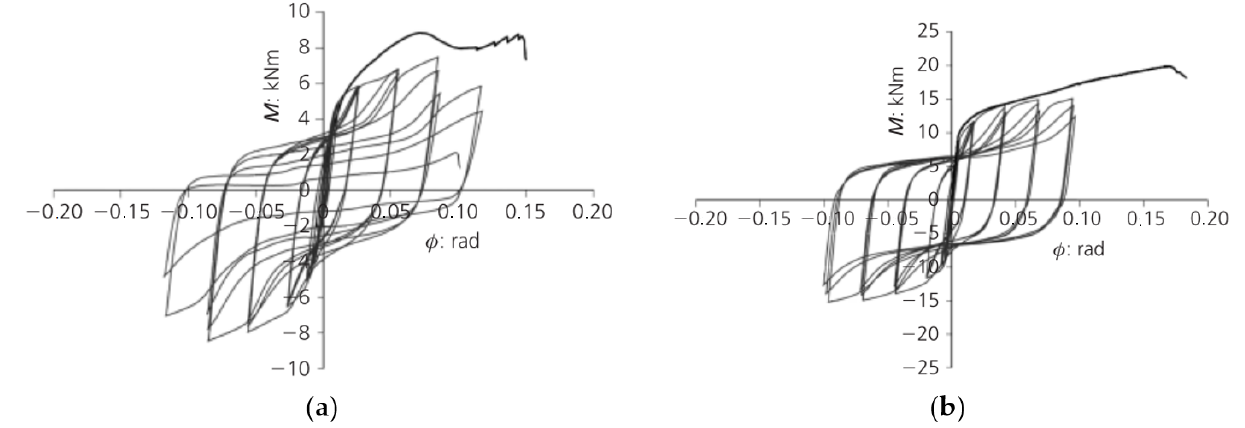
Figure 20. Monotonic and cyclic moment–rotation relationship experimental results for ( a ) specimen P6, ( b ) specimen P10, (adapted from [54]).